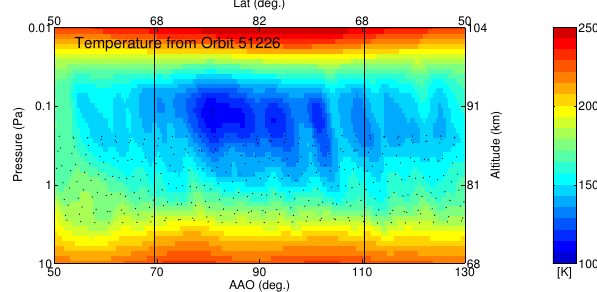
Figure 8. Temperature retrieved from orbit 51226 on 15 July 2010. The lower x -axis shows the AAO and the top axis shows the true latitude of the measurements. The black lines indicate the positions of collocated ACE-FTS and AIM-SOFIE measurements. The black dots are the tangent position for each